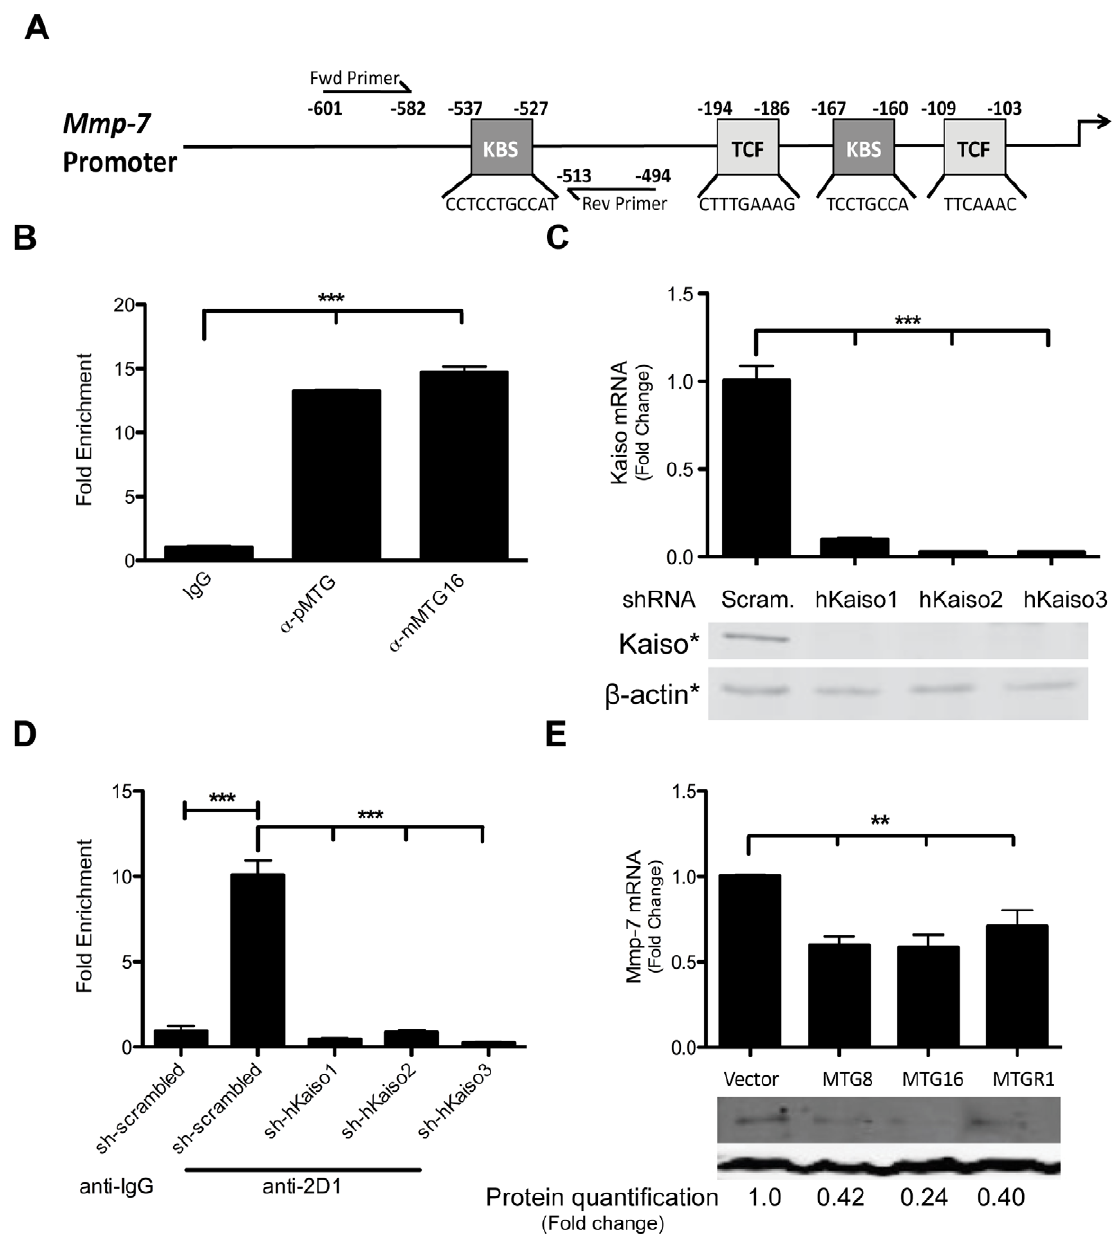
Figure 5. MTG family members repress endogenous MMP-7 . A. Primers for the ChIP assay flank the 2 537 Kaiso binding site in the MMP-7 promoter. B. ChIP assay performed in HCT116 cells using both polyclonal (333, pMTG) and monoclonal (2D1, mMTG16) antibodies for MTG16. The graph shows fold-enrichment compared to IgG control. C. Knockdown of Kaiso by three independent shRNA constructs compared to a scrambled sh- RNA control. D. Chromatin immunoprecipitation assay in HCT116 cells. The graph shows fold enrichment of the 2 537 Kaiso binding site after precipitation with the MTG16 2D1 antibody compared to the IgG control. E. MMP-7 mRNA expression after transfection of the indicated MTG family member in HT29 cells. The graph shows the fold-change ( DD Ct) of MMP-7 mRNA compared to an empty control. Error bars represent the standard error for three replicate experiments performed in triplicate (top). Representative immunoblotting of MMP-7 in HT29 cells after transfection of indicated family members and treatment with Brefeldin-A. Protein quantification was performed with the Odyssey Western blot developer system. ** P , 0.01, *** P , 0.001.